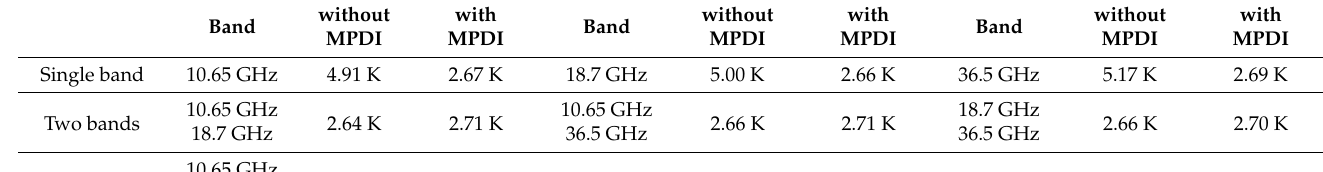
Figure 2. Coefficient of correlation (R) between brightness temperature (36.5 GHz) and MODIS LST. ( a ) before cubic interpolation. ( b ) after cubic interpolation. The darker color indicates a stronger correlation between two variables. Table 3. The groups of variables used in the random forest-based LST estimation and their RMSE.